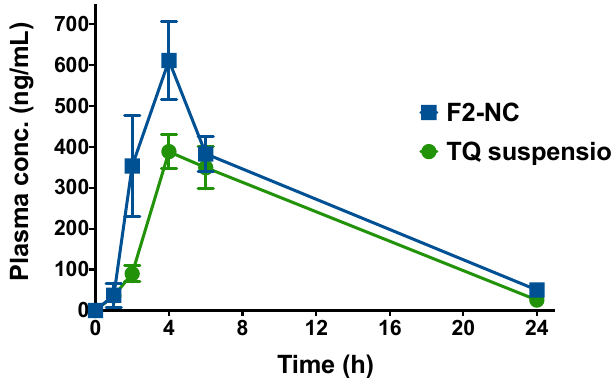
Figure 7. Plasma concentration versus time profiles following oral administration of TQ suspension or